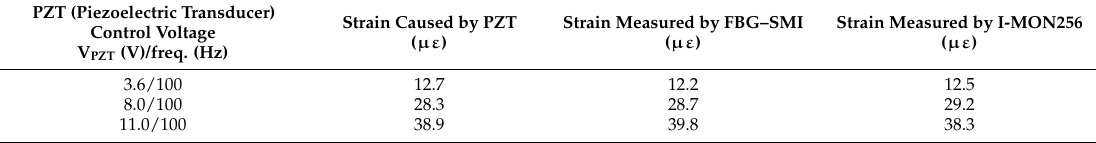
Table 1. Comparison of the strain measured by the FBG–SMI system and I-MON 256 system. PZT (Piezoelectric Transducer) Strain Caused by PZT Control Voltage ( µε ) V PZT (V)/freq. (Hz)